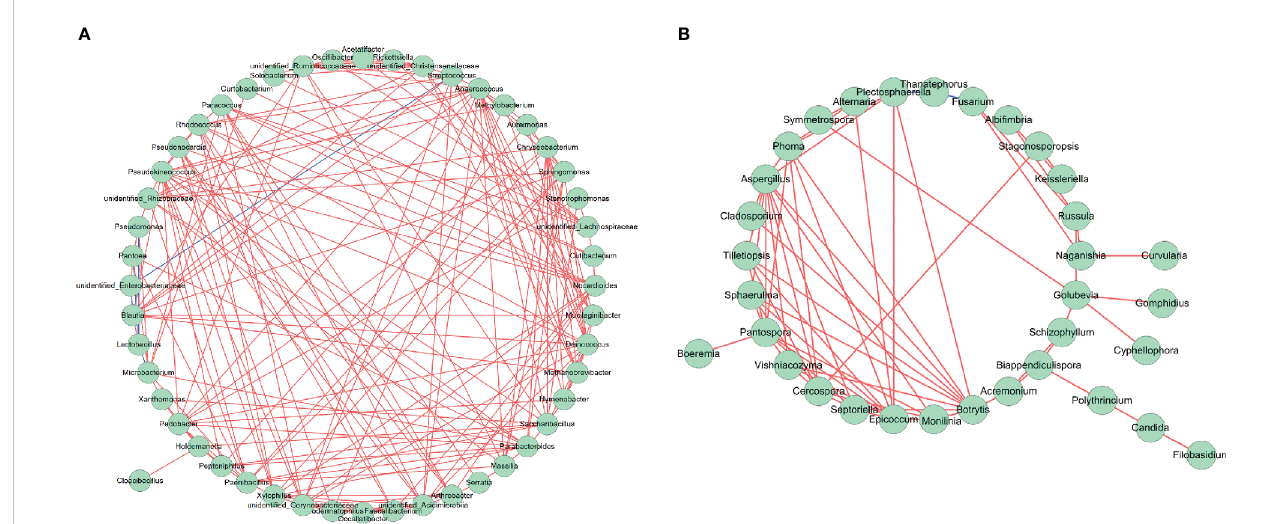
FIGURE 12 Network analysis of bacterial (A) and fungal (B) taxa showing signi fi cant positive or negative co-occurrences based on Spearman ’ s rank correlations. Red lines represent positive correlations and blue lines represent negative